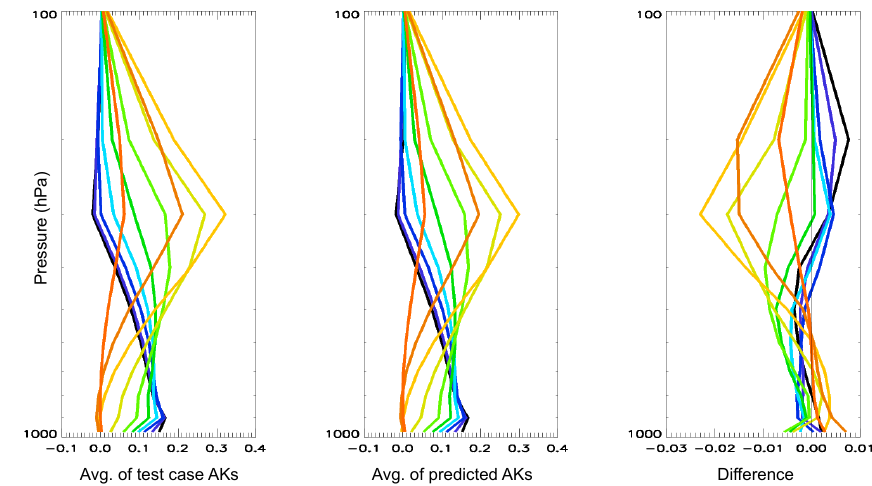
Fig. 13. Comparison of the average CO AK for MOPITT test cases and average of corresponding predicted AKs. Difference between average Figure 13. Comparison of the average CO AK for MOPITT test cases and average of predicted and average test case AKs is shown on the right. corresponding predicted AKs. Differences between average predicted and average test case AKs are shown on the right.